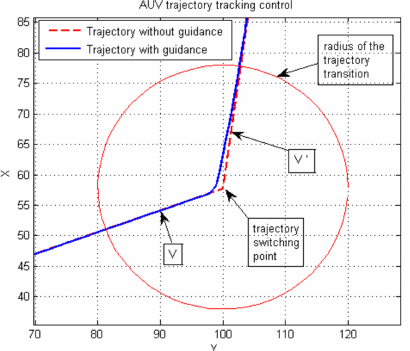
Figure 3. AUV trajectory tracking control based on the Line-of-Sight